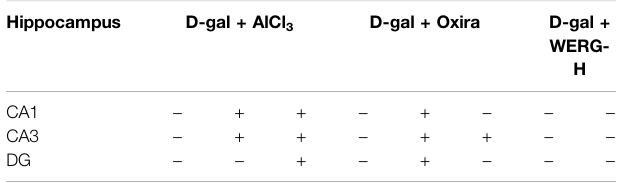
TABLE 1 | P-Tau Thr231 -positive structures in D-gal/AlCl 3 -induced AD-related tauopathy. Hippocampus D-gal + AlCl 3 D-gal + Oxira D-gal +